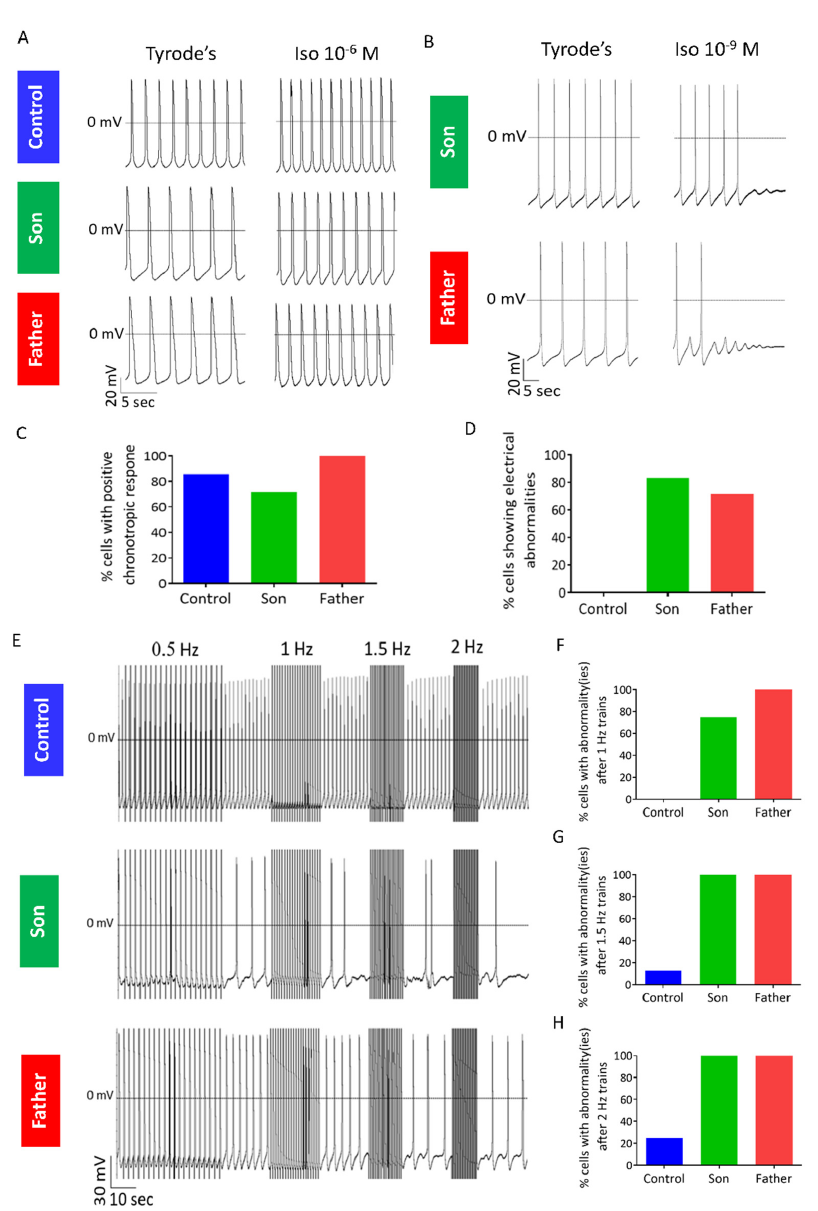
Figure 6. Abnormal response of LMNA -mutated cardiomyocytes to β -adrenergic stimulation and rapid pacing. ( A ) AP recordings from control, son and father cardiomyocytes showing a positive chronotropic response to isoproterenol. ( B ) Representative AP recordings from father and son cardiomyocytes showing afterdepolarization/s and cessation of spontaneous AP firing in response to isoproterenol. ( C ) Percentage of cells showing positive chronotropic response to isoproterenol ( n = 7 control; n = 7 son; n = 7 father). ( D ) Percentage of cells showing electrophysiological abnormalities in response to isoproterenol ( n = 7 control; n = 6 son; n = 7 father). ( E ) Representative recordings of trains protocol in control, son and father cardiomyocytes. ( F – H ) Percentage of cells showing electrical abnormality(ies) following stimulation at ( F ) 1 Hz ( n = 6 control (FSE-5 m and 24.5); n = 4 son; n = 4 father), ( G ) 1.5 Hz ( n = 8 control (FSE-5 m and 24.5); n = 4 son; n = 4 father) and ( H ) 2 Hz ( n = 8 control (FSE-5 m and 24.5); n = 4 son; n = 3 father).